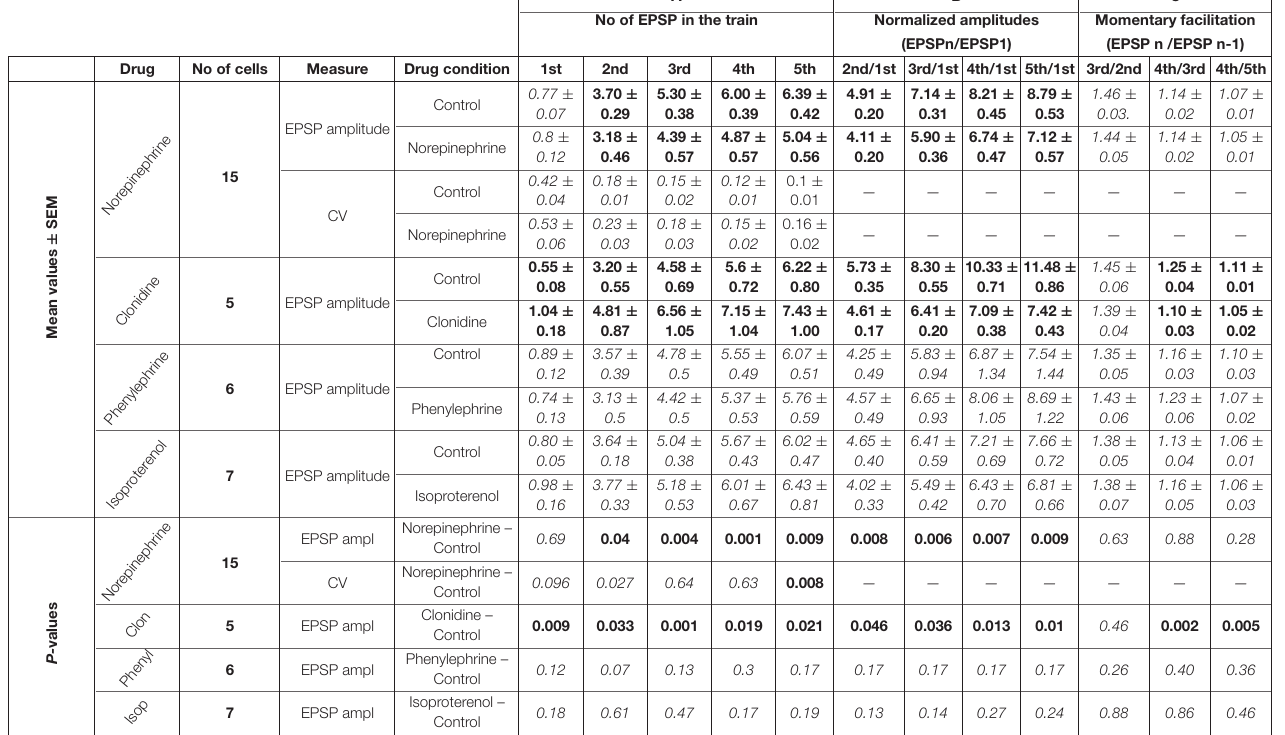
A B C No of EPSP in the